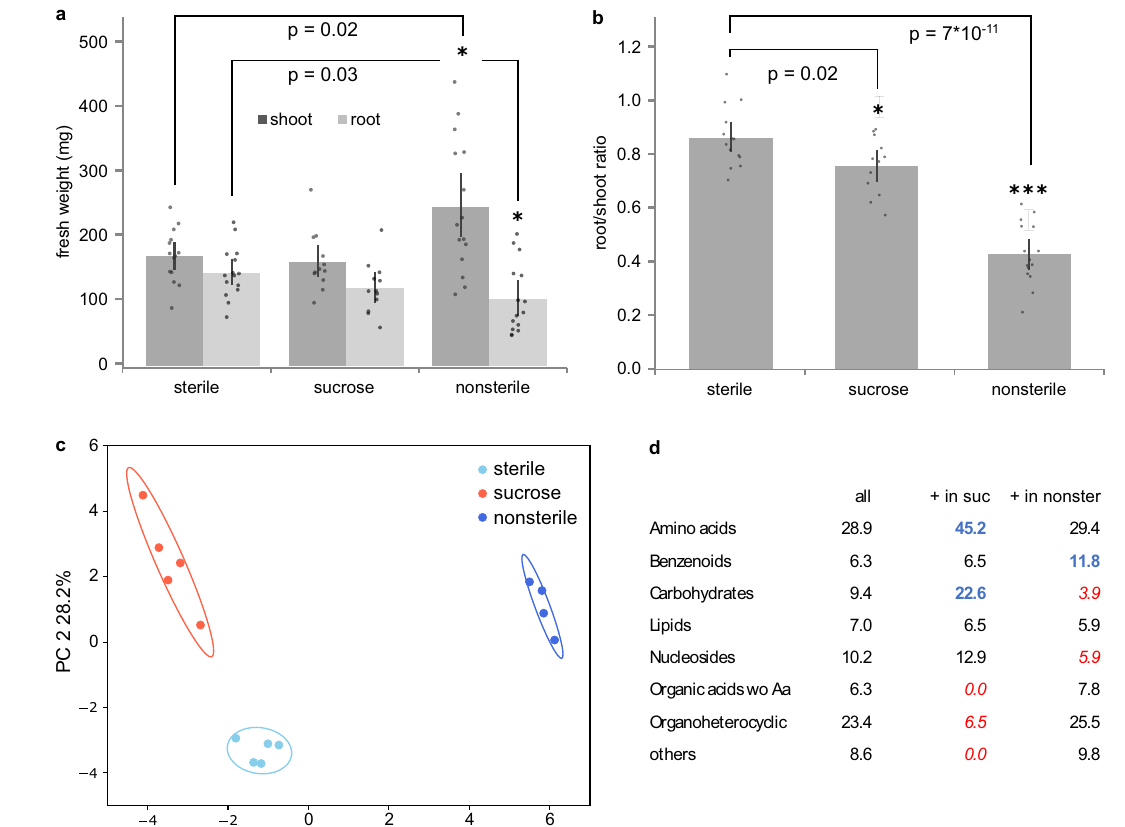
c Principalcomponentanalysisofexudatepro fi les. d Metaboliteclassesdetectedin the entire dataset, and classes enriched (bold, blue) or depleted (italic, red) in sucrose-supplemented or nonsterile conditions compared to sterile conditions (Fishers exact test). Values are in percent of total number of metabolites ( n =109 metabolites of 4 – 5 jars with 3 plants per growth condition). One representative experiment out of three is